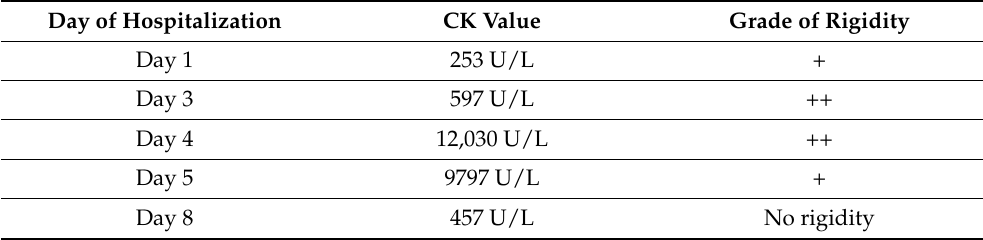
Figure 1. Imaging ( A – D ). Lung computed tomography shows bilateral areas of alveolar condensation and adjacent pleural effusion ( A , B ); Brain MRI-(DWI)—No areas of restricted diffusion were found ( C , D ). Table 1. Creatine Kinase values during hospitalization compared to grade of